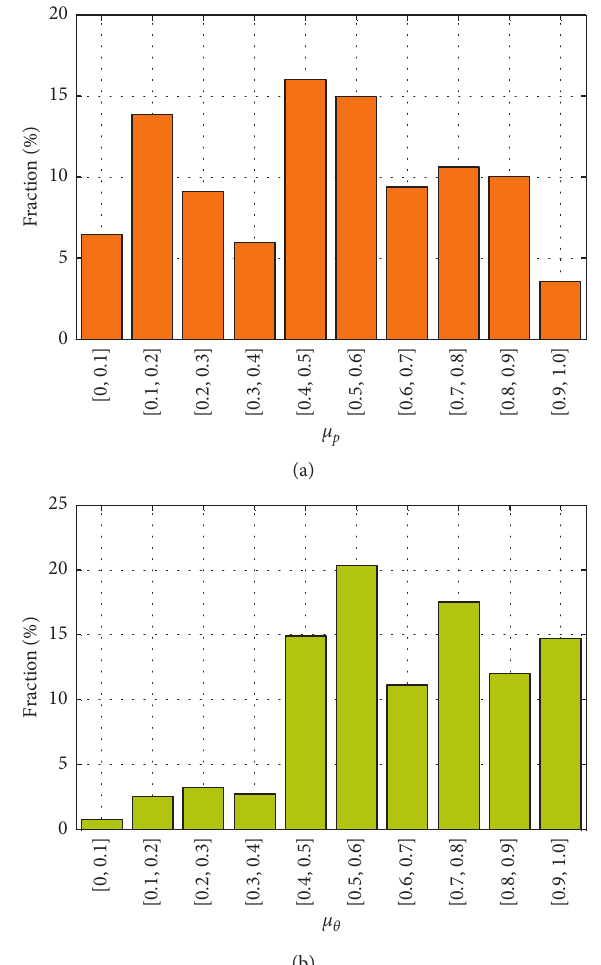
Figure 11: Statistical information of corroded pipe’s crack: (a) location; (b) evolution